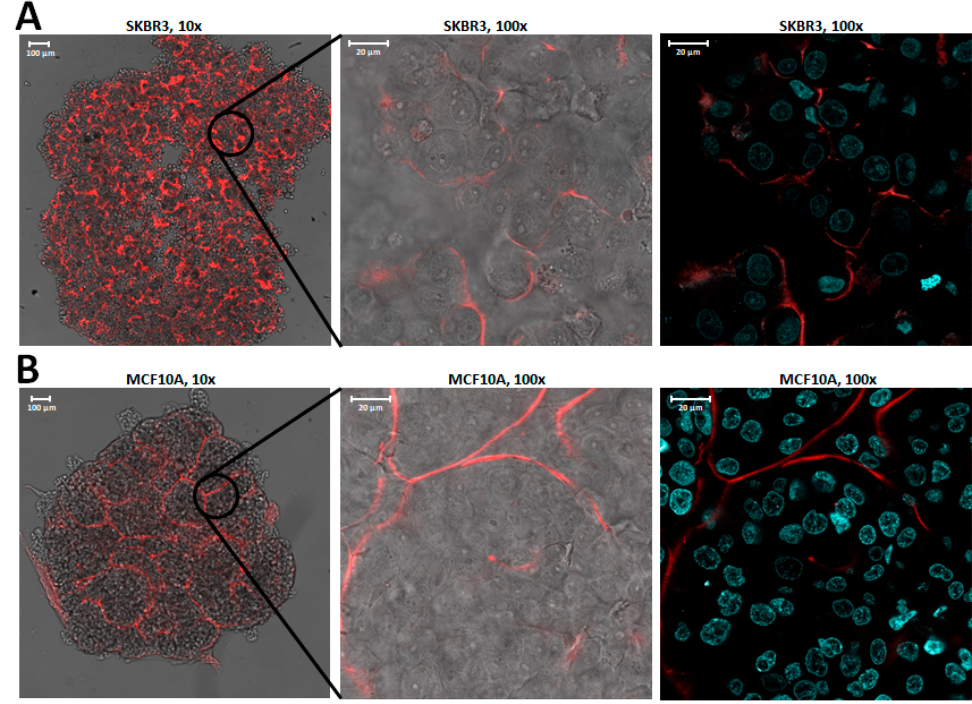
Figure 3. Images of spheroids incubated with full SKBR3-R1 aptamers labeled with Alexa Fluor 594 after one hour incubation at room temperature. Images on the left are at 10×, images in the middle at 10× magnification, bright field, and AF594 signal (red). The images on the right show Hoechst-stained nuclei (cyan) and the AF594 signal (red). Panel ( A ), SKBR3 spheroids. Panel ( B ), MCF10A spheroids.